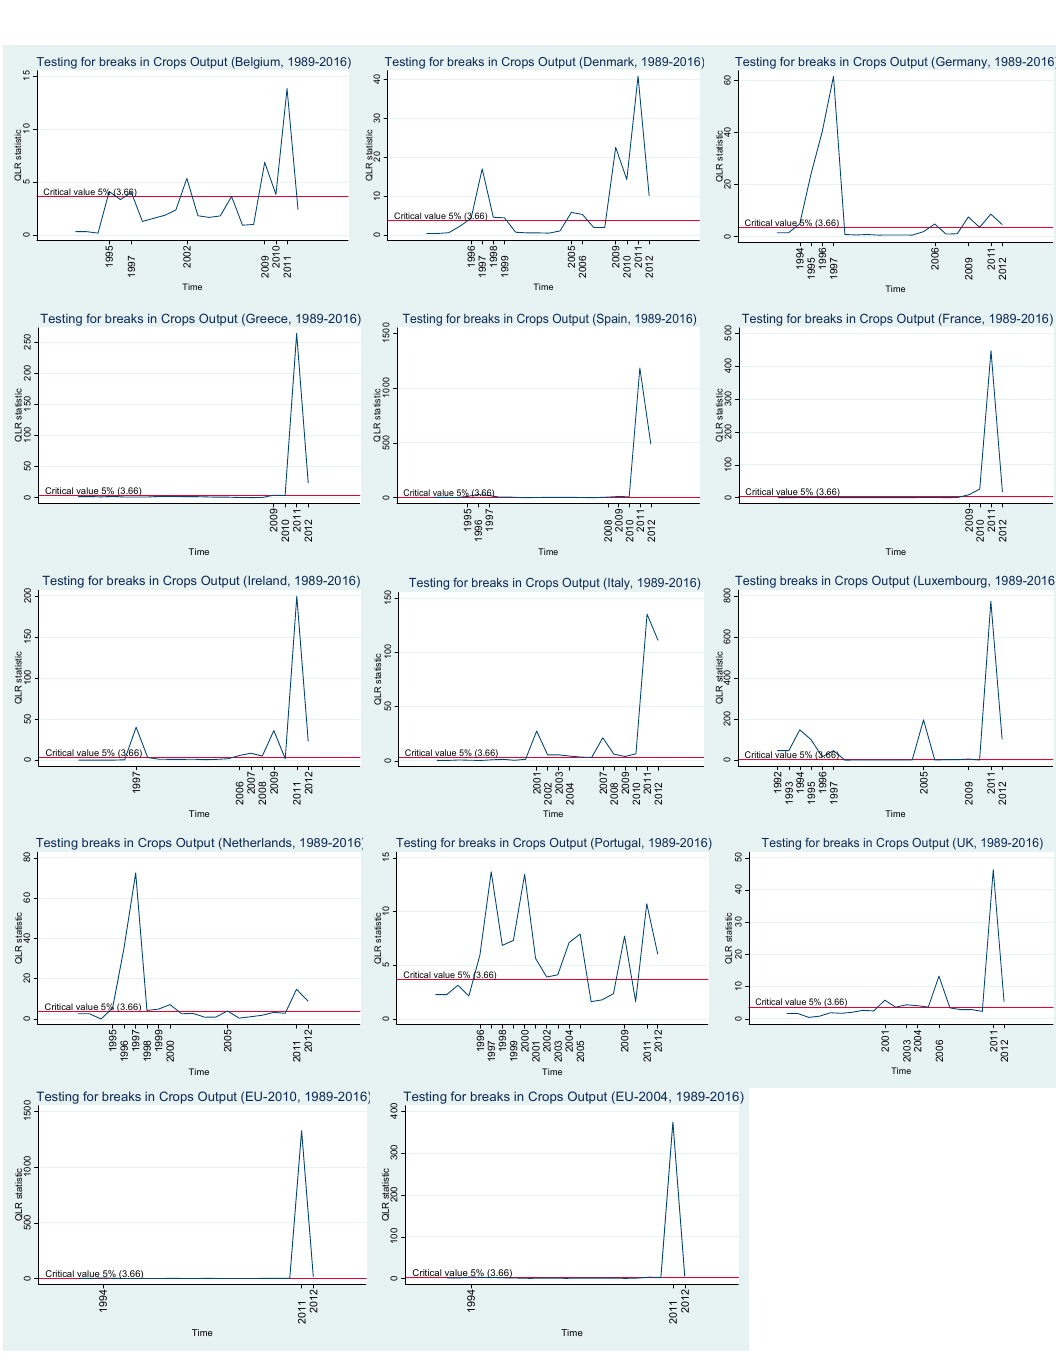
Figure 6. Testing for breaks in crops output (euros) over the European Union countries (1989–2016).